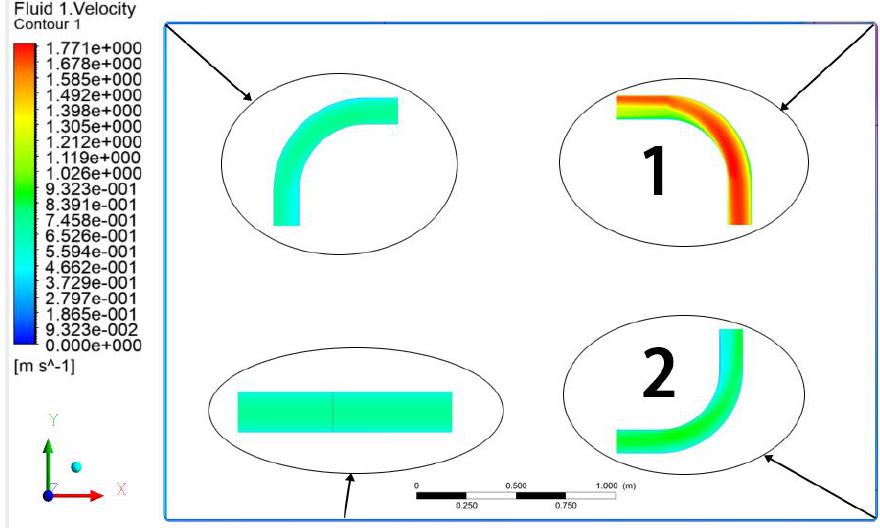
Figure 6. Velocity distribution of supercritical water natural circulation loop.